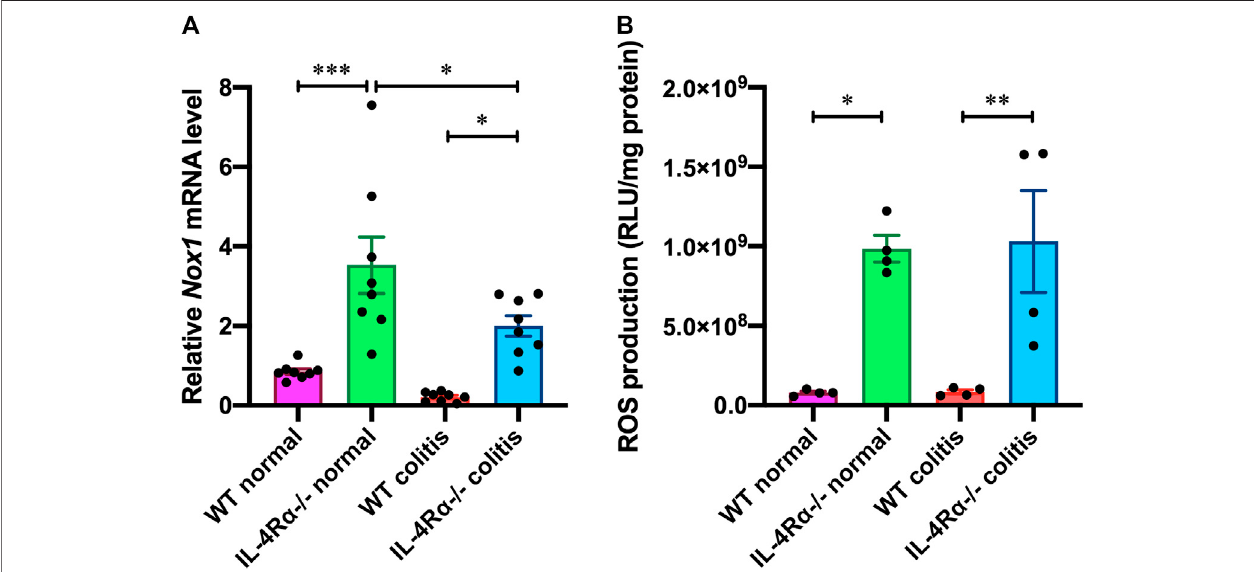
FIGURE5| IL-4R α de fi ciencyincreasesNOX1-dependent ROSproduction inthecolonofmouse. (A) ThemRNAexpression levelof Nox1 inthecolonsofWTand IL-4R α -/- mice. The data are presented as the mean ± SEM values for eight mice. * p < 0.05; *** p < 0.001. (B) ROS production (RLU, relative luminescence units) in the colons of WT and IL-4R α -/- mice. The data are presented as the mean ± SEM values for four mice and are representative of one of two independent experiments. * p < 0.05; ** p < 0.01.